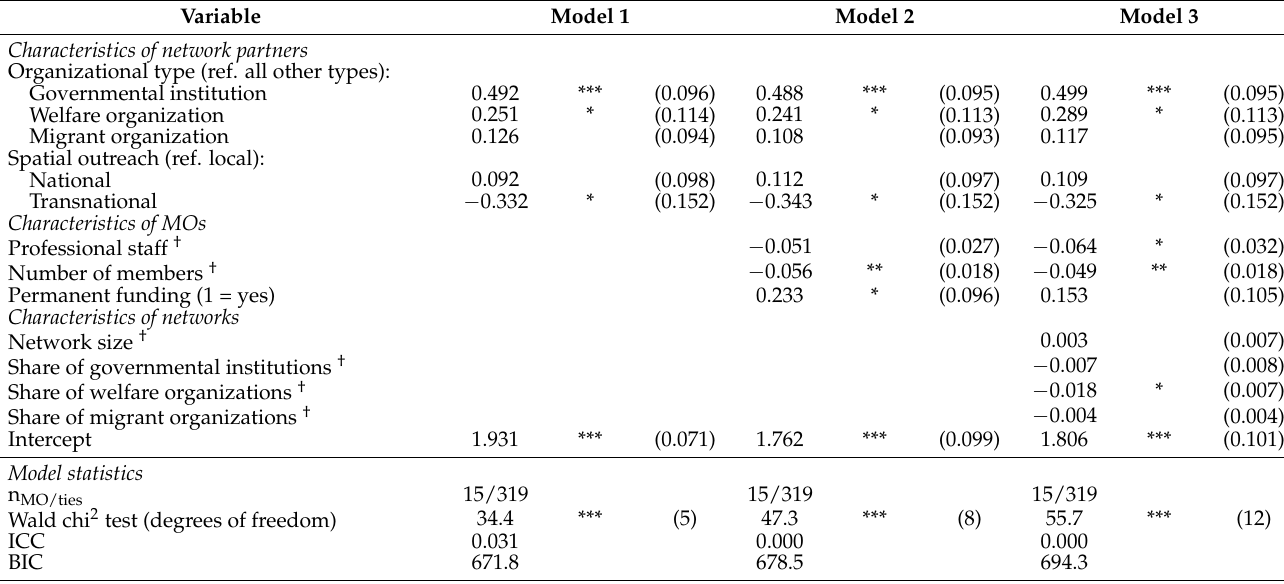
Table A2. Regression models of the relevance of network